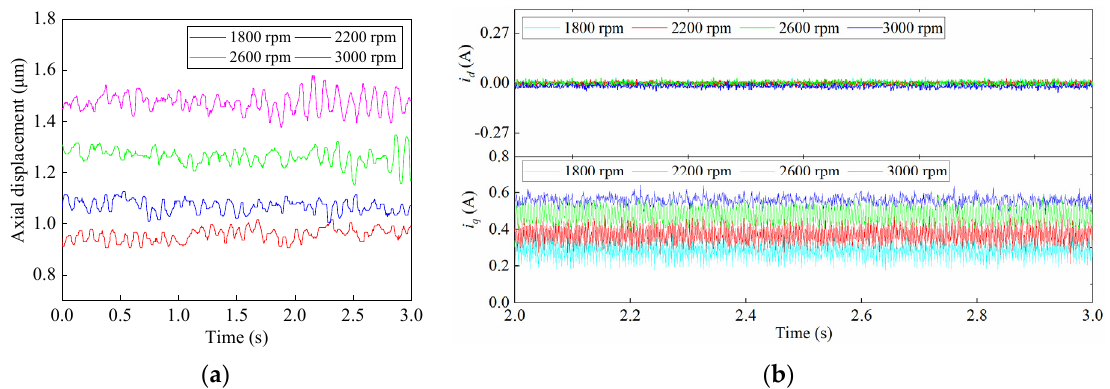
Figure 17. Axial displacement and current waveform corresponding to different rotating speeds of the blood pump impeller: ( a ) Axial displacement; ( b ) Current waveform.